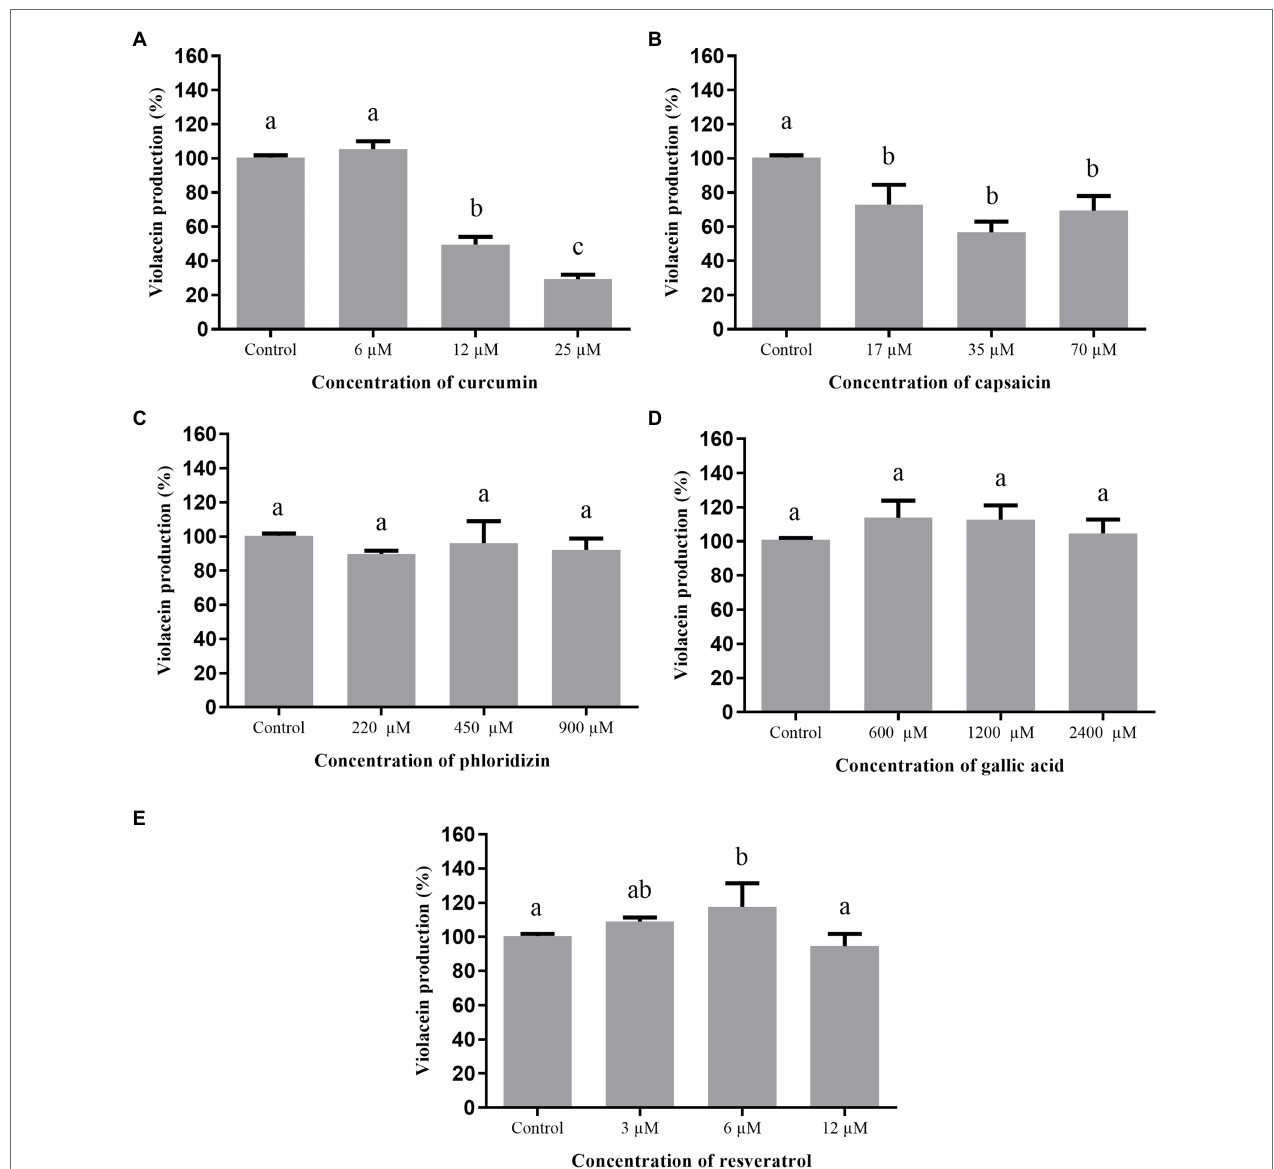
FIGURE 3 | Effect of phenolic compounds on violacein production by Chromobacterium violaceum 026 in the presence of C6-HSL, expressed as percentage of production, when compared to the control (100%). curcumin (A) ; capsaicin (B) ; phloridizin (C) ; gallic acid (D) ; resveratrol (E) ; and control = violacein production in LB broth + DMSO